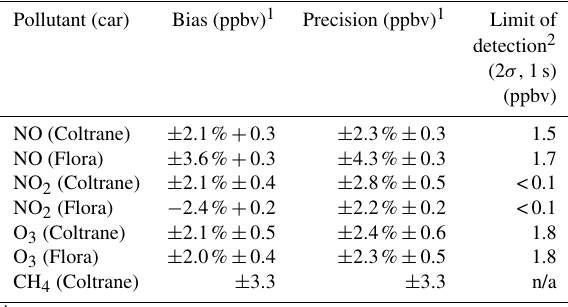
Table 5. Performance summary of the gas-phase instruments